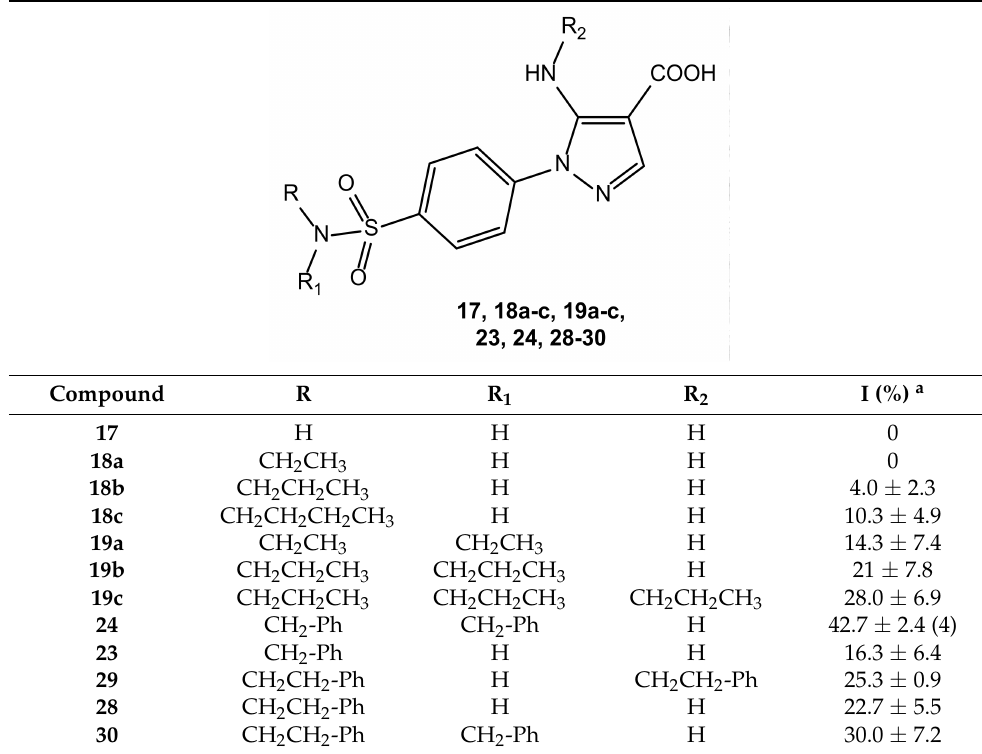
Table 3. Inhibition (%) values of compounds 17 , 18a – c , 19a – c , 23 , 24 and 28 – 30